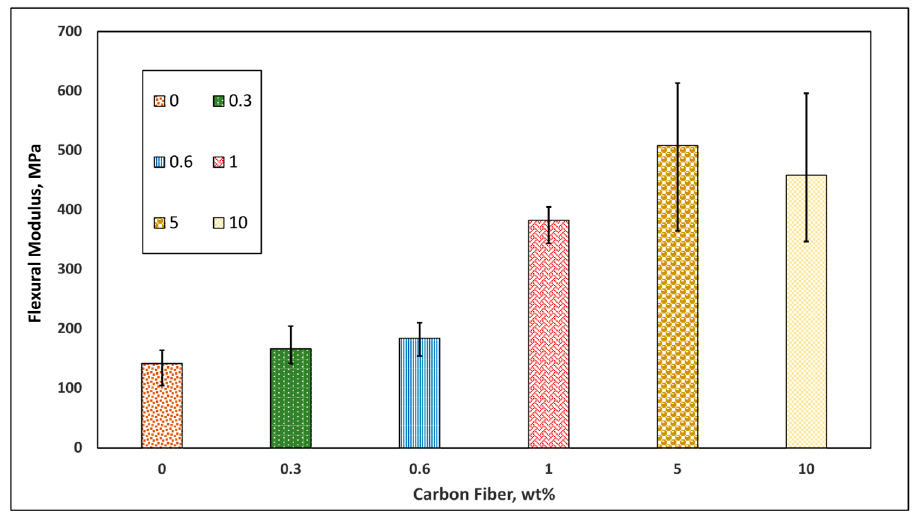
Figure 4. E ff ect of carbon fi ber content in SLS-Printed fully cured thermose tt ing samples on Young’s Modulus.